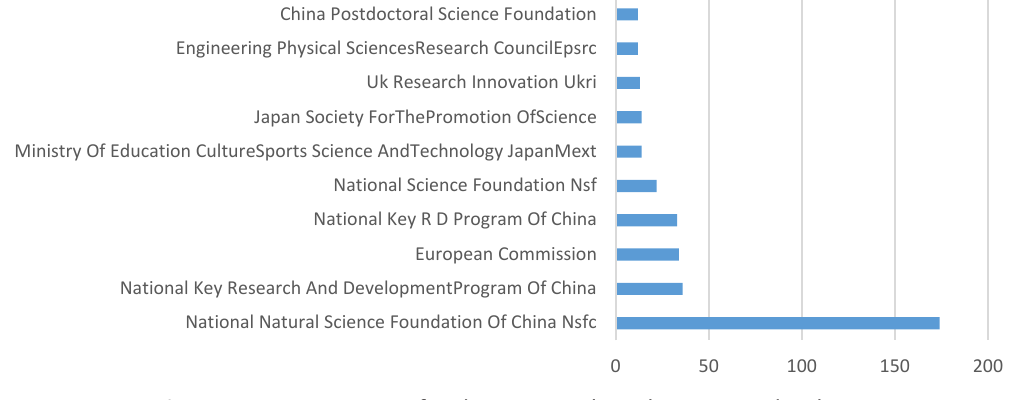
Figure 9. Organizations funding research in the Scopus database